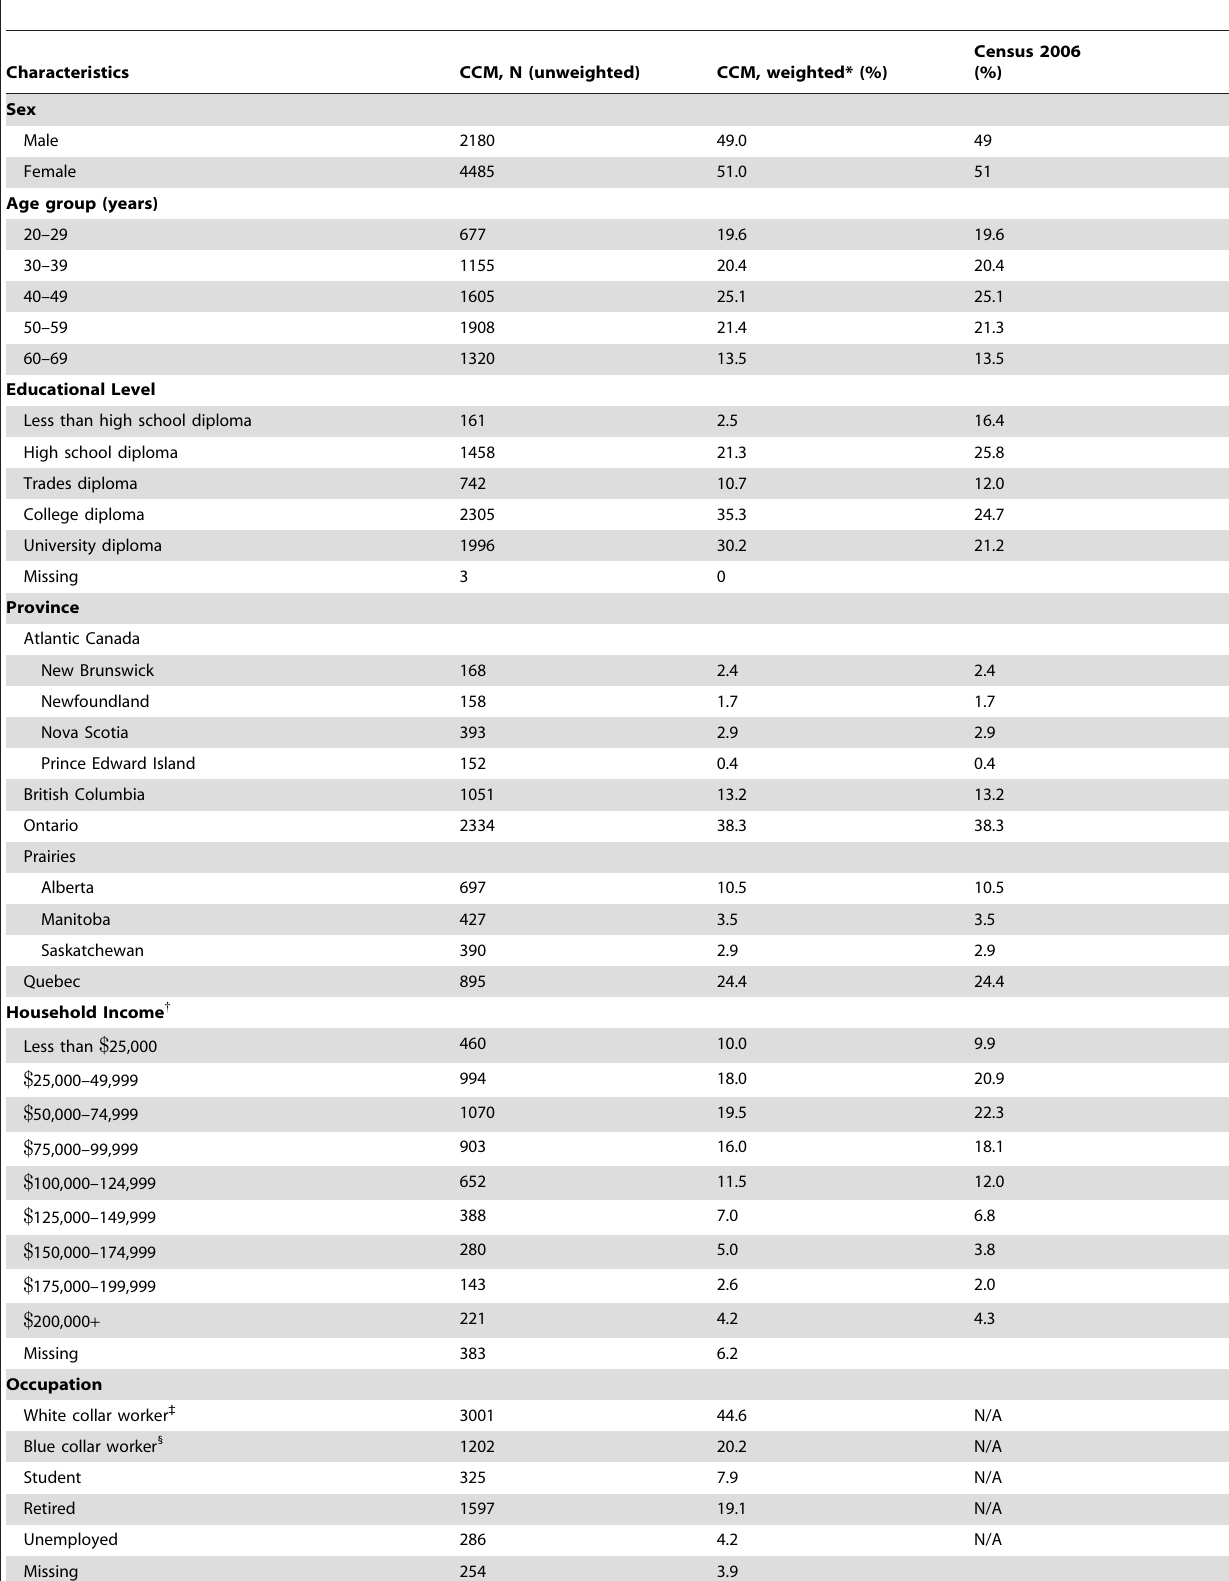
Table 1. Demographic characteristics of CCM survey respondents (N =6665), unweighted and weighted responses based on 2006 census